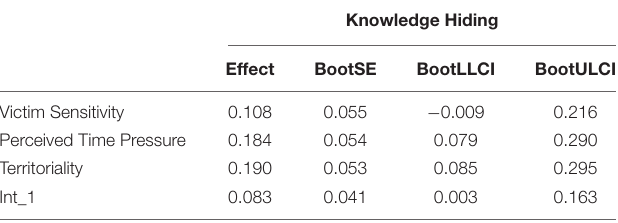
TABLE 7 | Moderated mediating regression coefficients and significance of victim sensitivity.